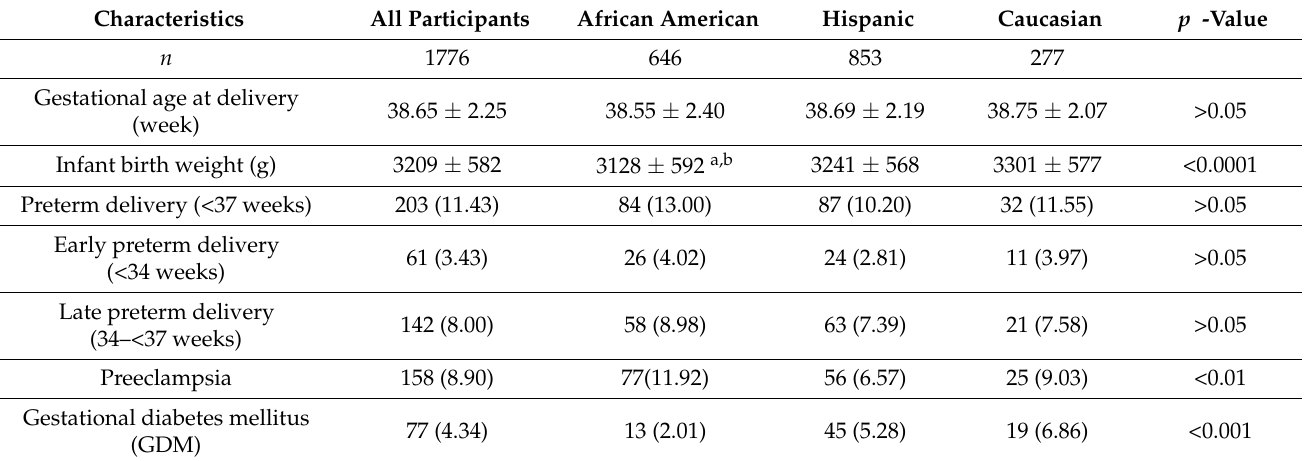
Table 2. Adverse pregnancy outcomes by